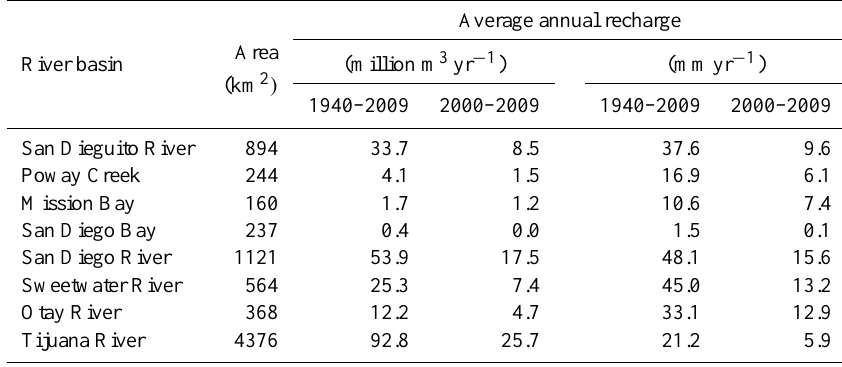
Table 3. Average annual recharge calculated using the Basin Characterization Model for all river basins in the San Diego/Tijuana study area for 1940–2009.